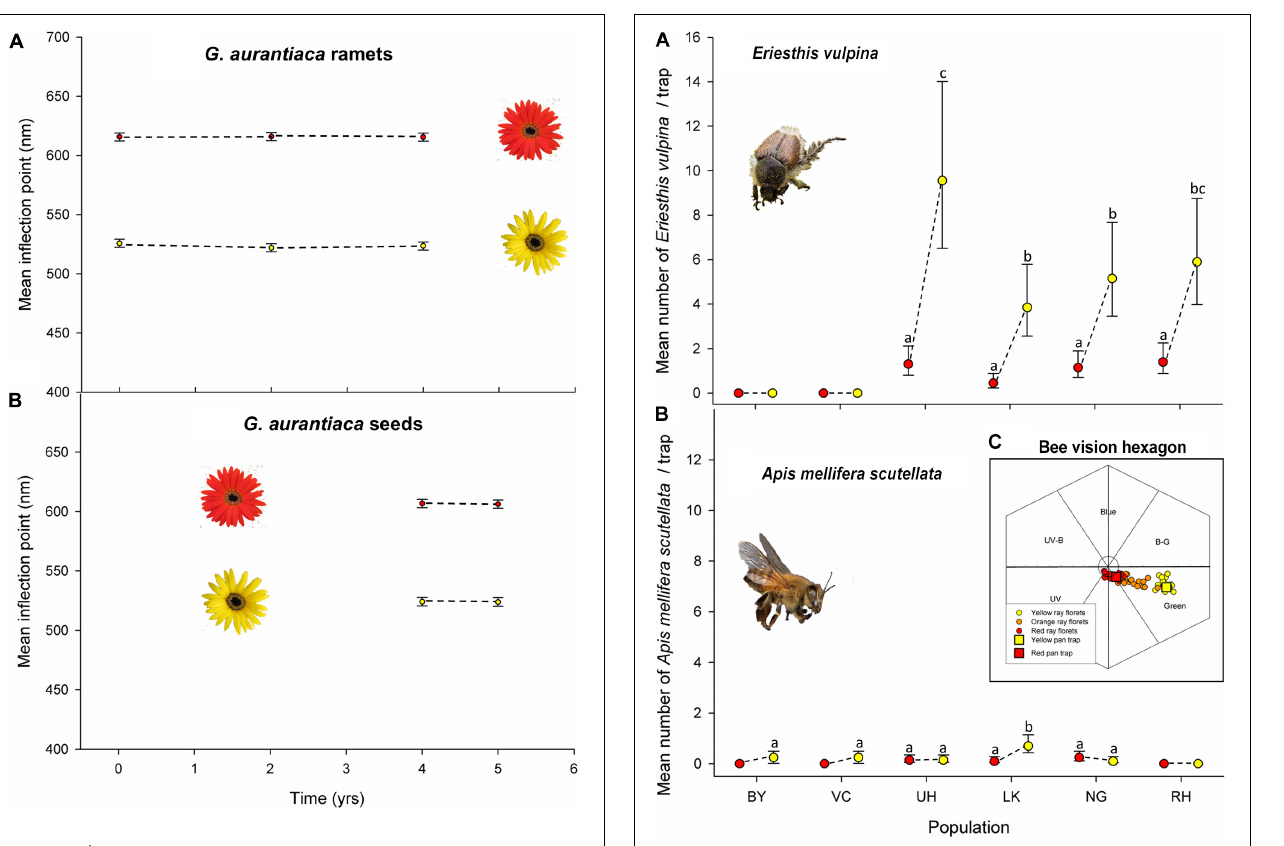
FIGURE 5 | Mean inflection points of the ray florets of Gerbera aurantiaca plants cultivated in a common garden of (A) ramets from the BY and NG populations at collection and after 2 and 5 years, and (B) from seed collected from the LM and NG populations after 4 and 5 years. Vertical bars indicate 95% confidence intervals.